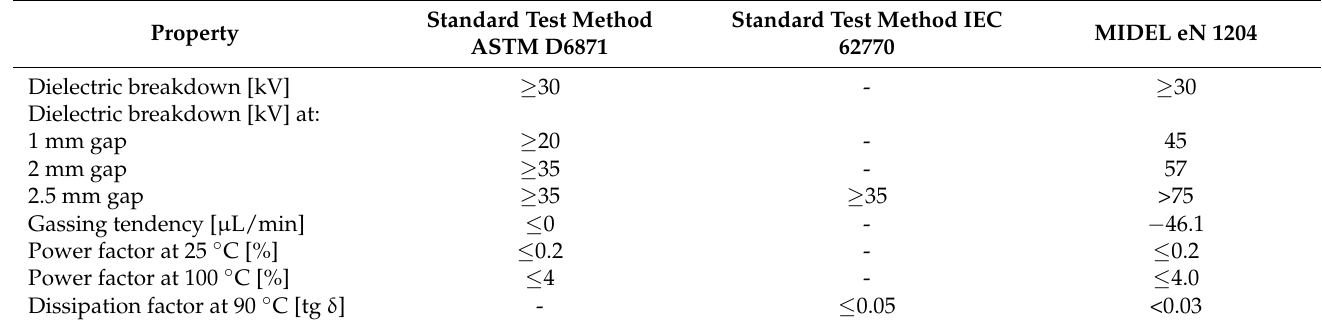
Table 2. Electrical properties of natural ester oil MIDEL eN 1204 [8].